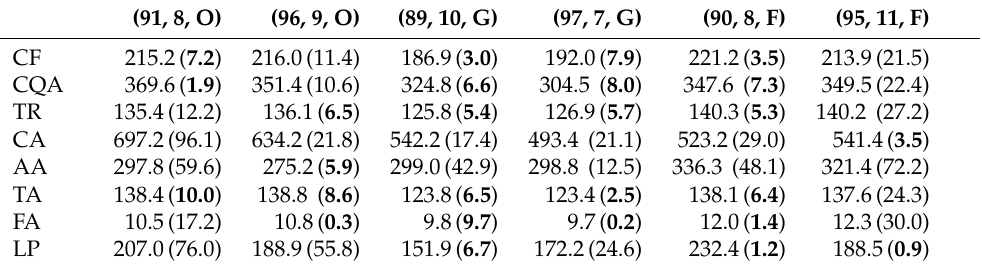
Table 9. Amount (mg) of the chemical species at the end of the percolation process for Arabica variety. The percentage error between numerical and laboratory results is in brackets. The extraction point is denoted by ( T , p , r ) .